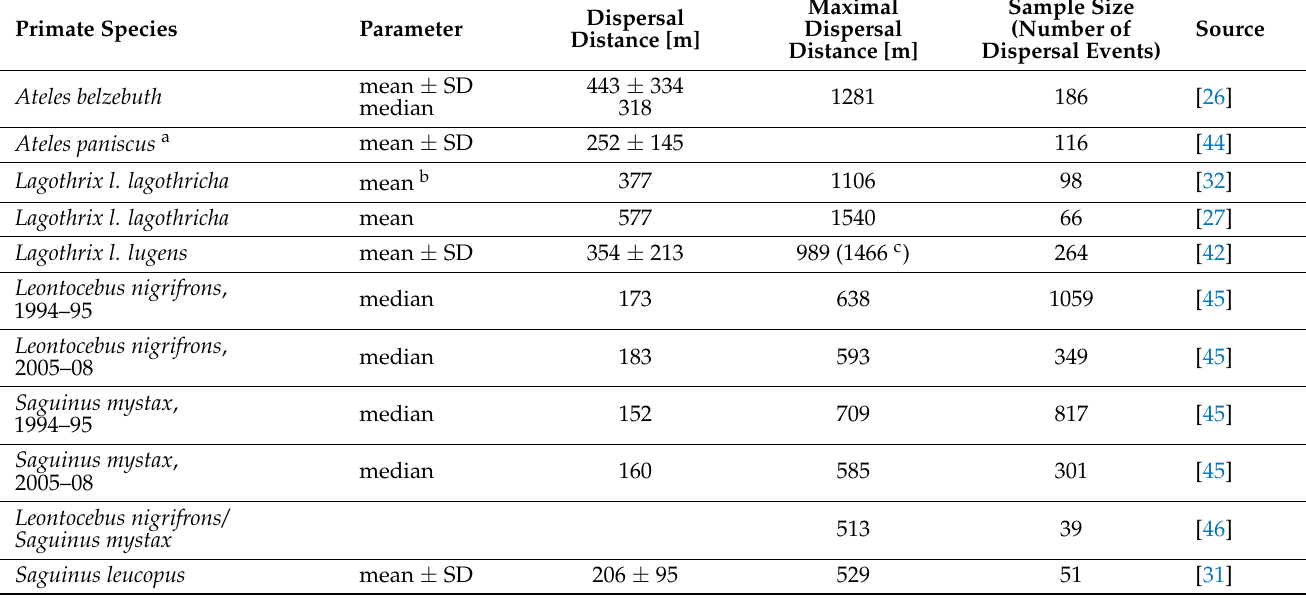
Table 7. Seed dispersal